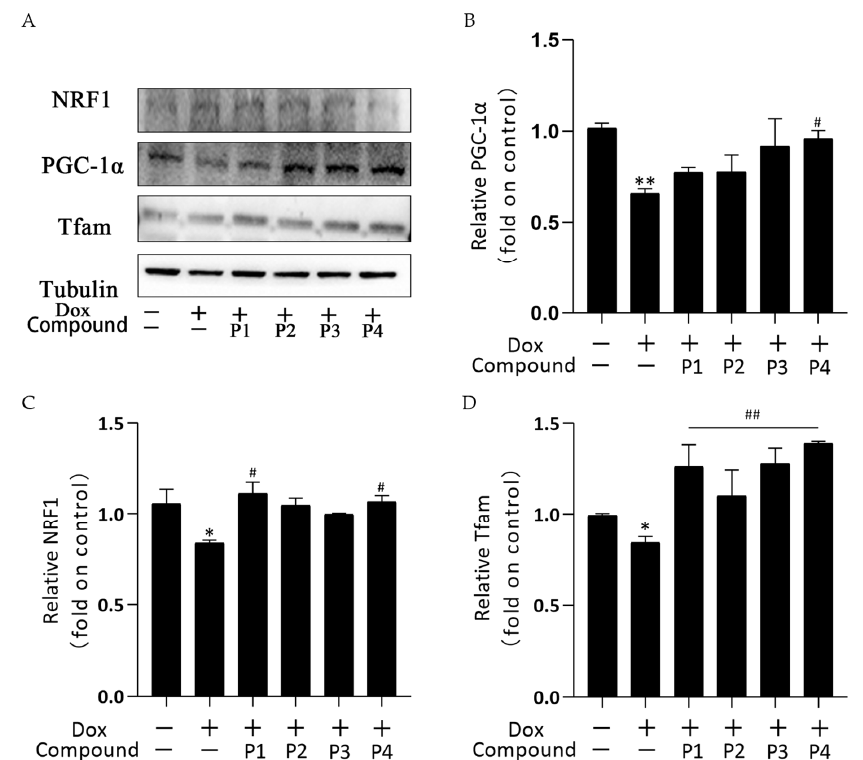
Figure 7. Effects of Hippophae rhamnoides L. phenylpropanoids on mitochondrial biogenesis in zebrafish. ( A ) PGC-1 α , NRF1, and Tfam protein expression determined using western blotting. ( B ) Column chart of quantitative analysis of PGC-1 α protein expression in zebrafish. ( C ) Column chart of quantitative analysis of NRF1 protein expression in zebrafish. ( D ) Column chart of quantitative analysis of Tfam protein expression in zebrafish. * p < 0.05, ** p < 0.01 vs. the control group; # p < 0.05, ## p < 0.01 vs. the Dox group.